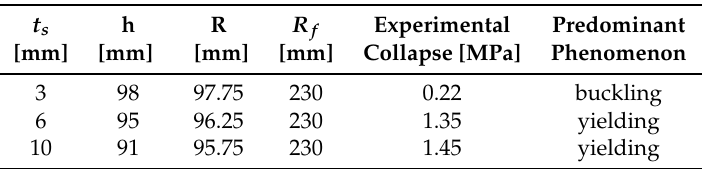
Table 6. Dome experimental